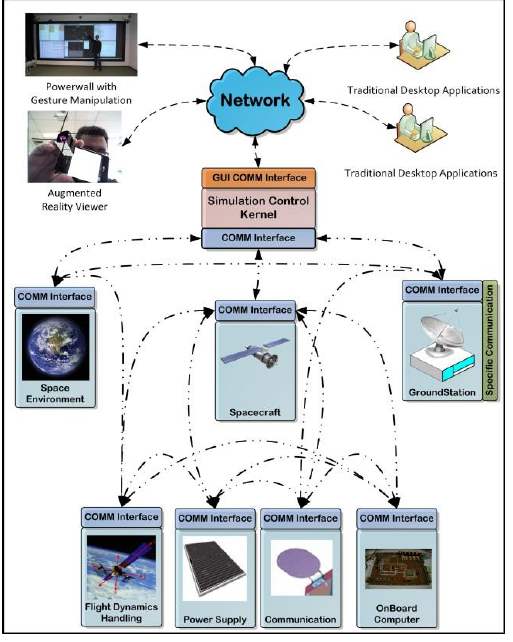
Fig. 19. Multiple interfaces connecting distributed simulation